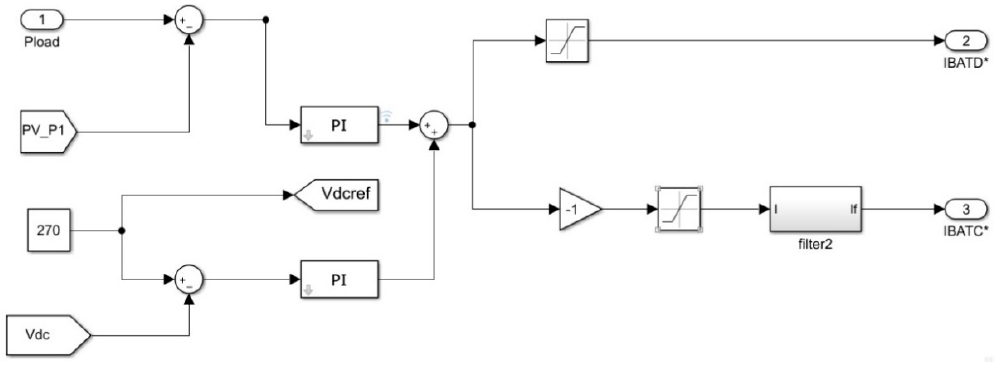
Figure 15. PI control strategy for battery charge / discharge. Table 7. Simulation stages and its boundaries.